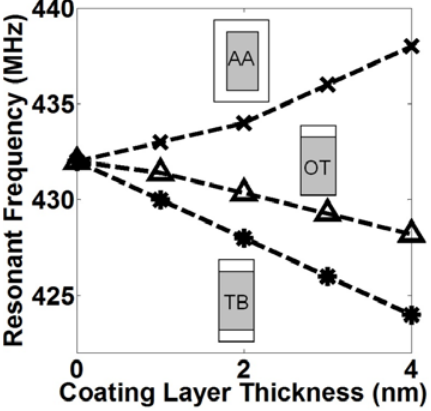
Figure 6. The resonant frequency versus coating layer thickness of the top and bottom (TB), only top (OT) and all-around (AA) configurations for the functionalization process in